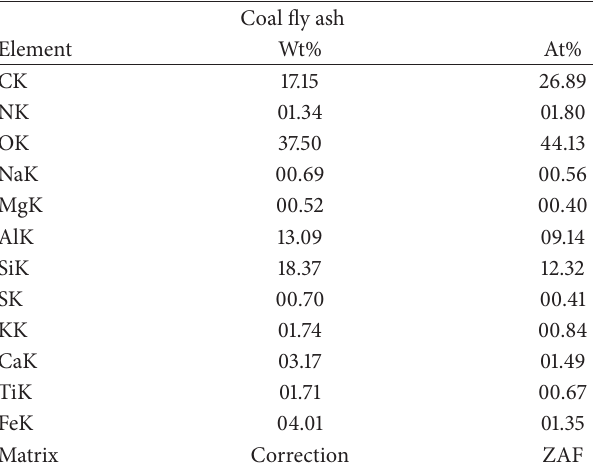
Table 1: Chemical properties of the coal fly ash from thermal power plant